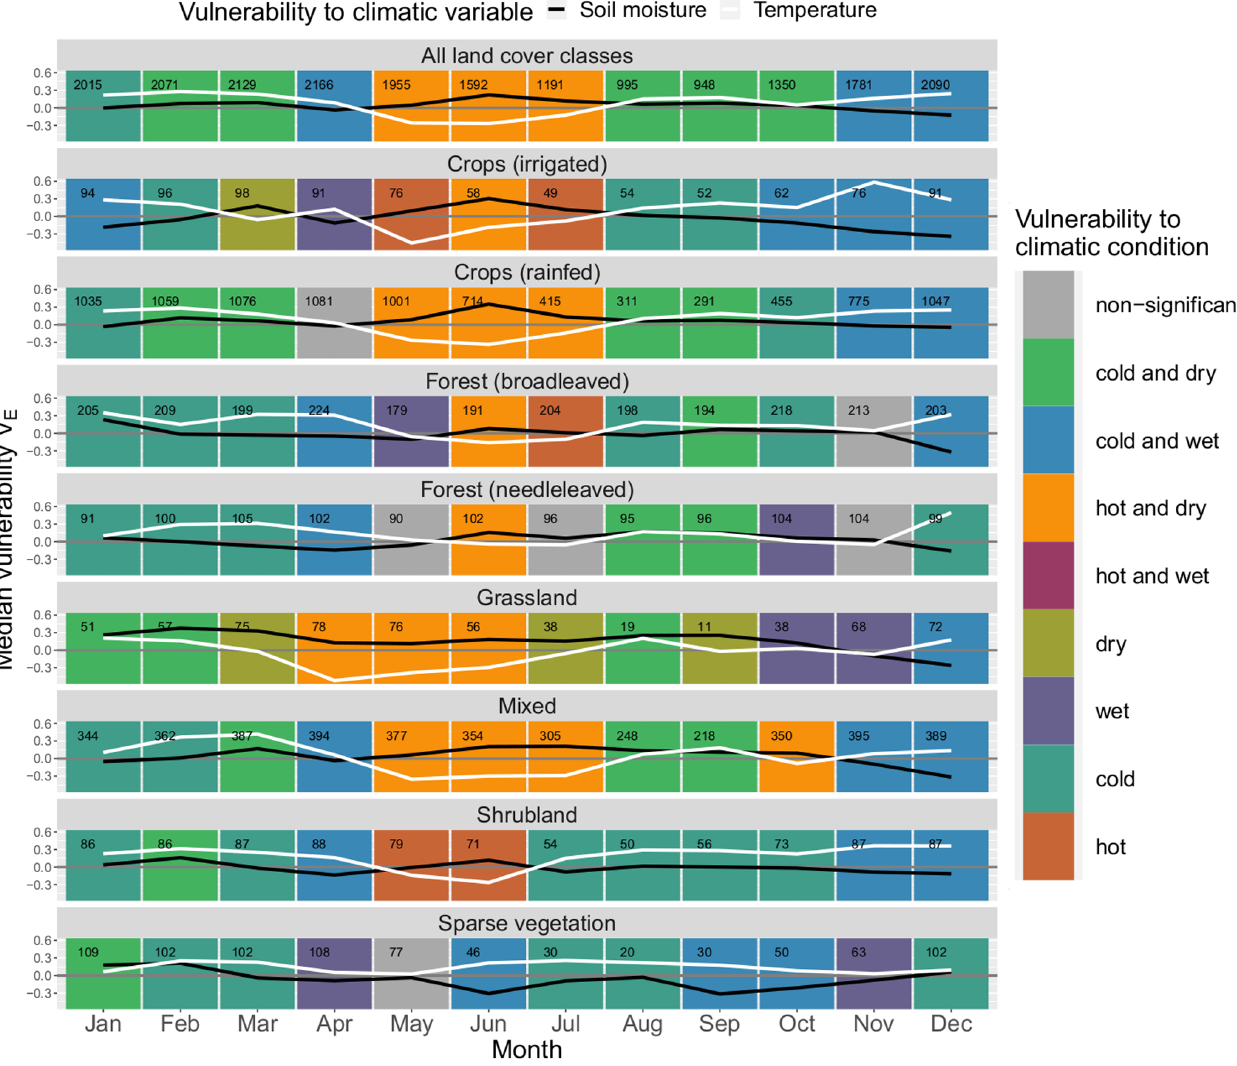
Figure A4. Median monthly ecosystem vulnerability per land cover. Vulnerability to temperature (ERA5-Land) is shown in white, and vulnerability to soil moisture (ERA5-Land at depth 28–100cm) is shown in black for each month of the year (columns) for each land cover (rows). Months with statistically significant deviation in climatic drivers during non-hazardous and hazardous ecosystem conditions according to the Mann–Whitney U test based on a significance level α = 0 . 05 are shown in colour (see legend); all other months are shown in grey. The number of grid points in which an event has occurred in this month and land cover within the period 1999–2019 is shown in the upper left corner of each